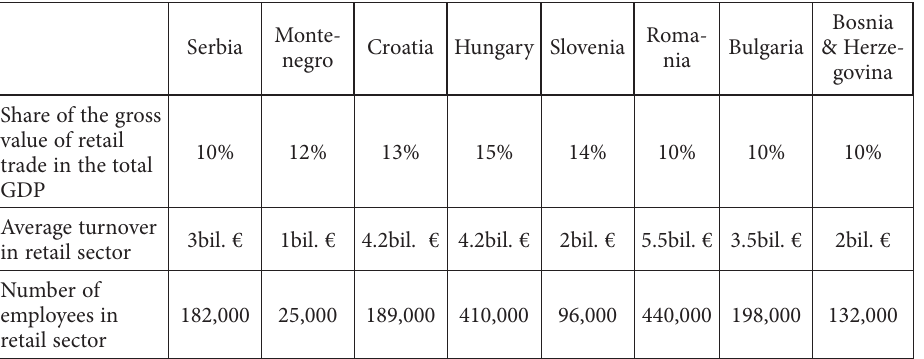
Table 1. Retail sector of selected CE and SEE countries (period 2016–2018)